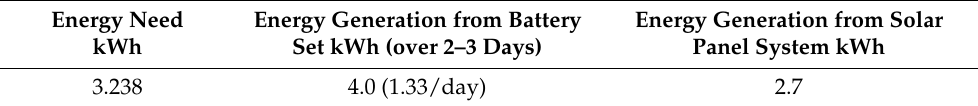
Table 2. Summary of golf cart energy requirement and energy generation from batteries and solar